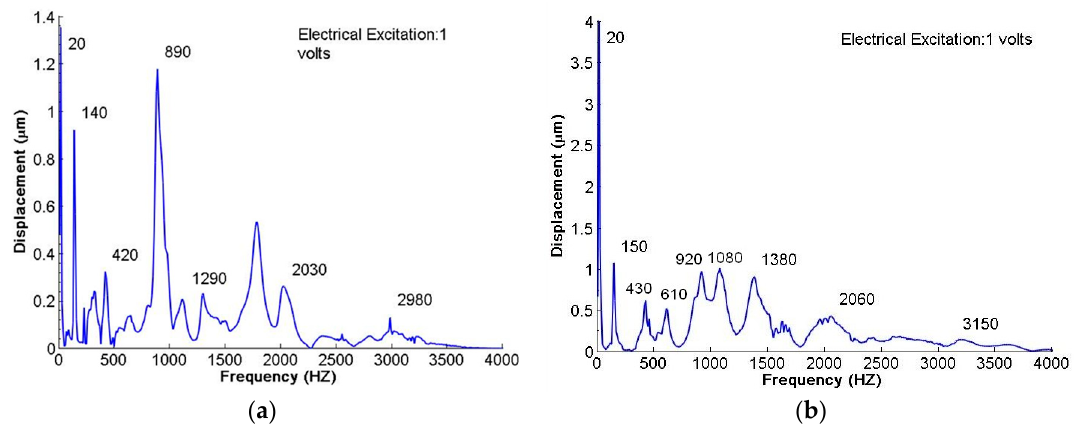
Figure 12. LDV displacement spectrum of water-coupled ( a ) anti-phase vibration and ( b ) in-phase vibration.